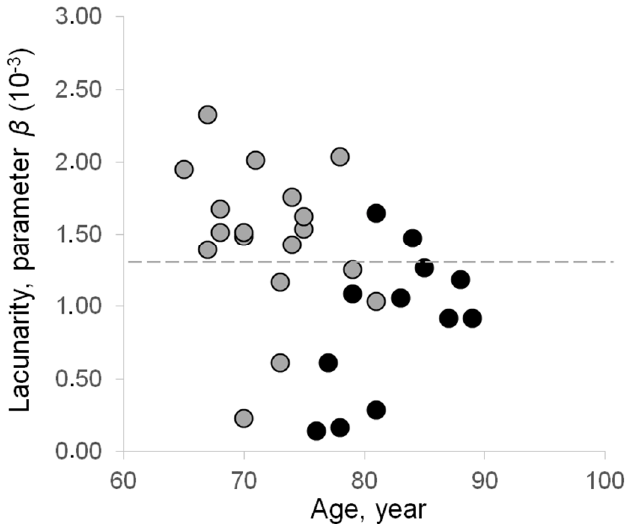
Figure 5. Age-related distribution of mtDNA lacunarity values in the senescent phenotype. A cut-off value at 1.26 × 10 − 3 of lacunarity parameter β is able to separate most normal aging (gray circle) and pathological aging (black circle) subjects.